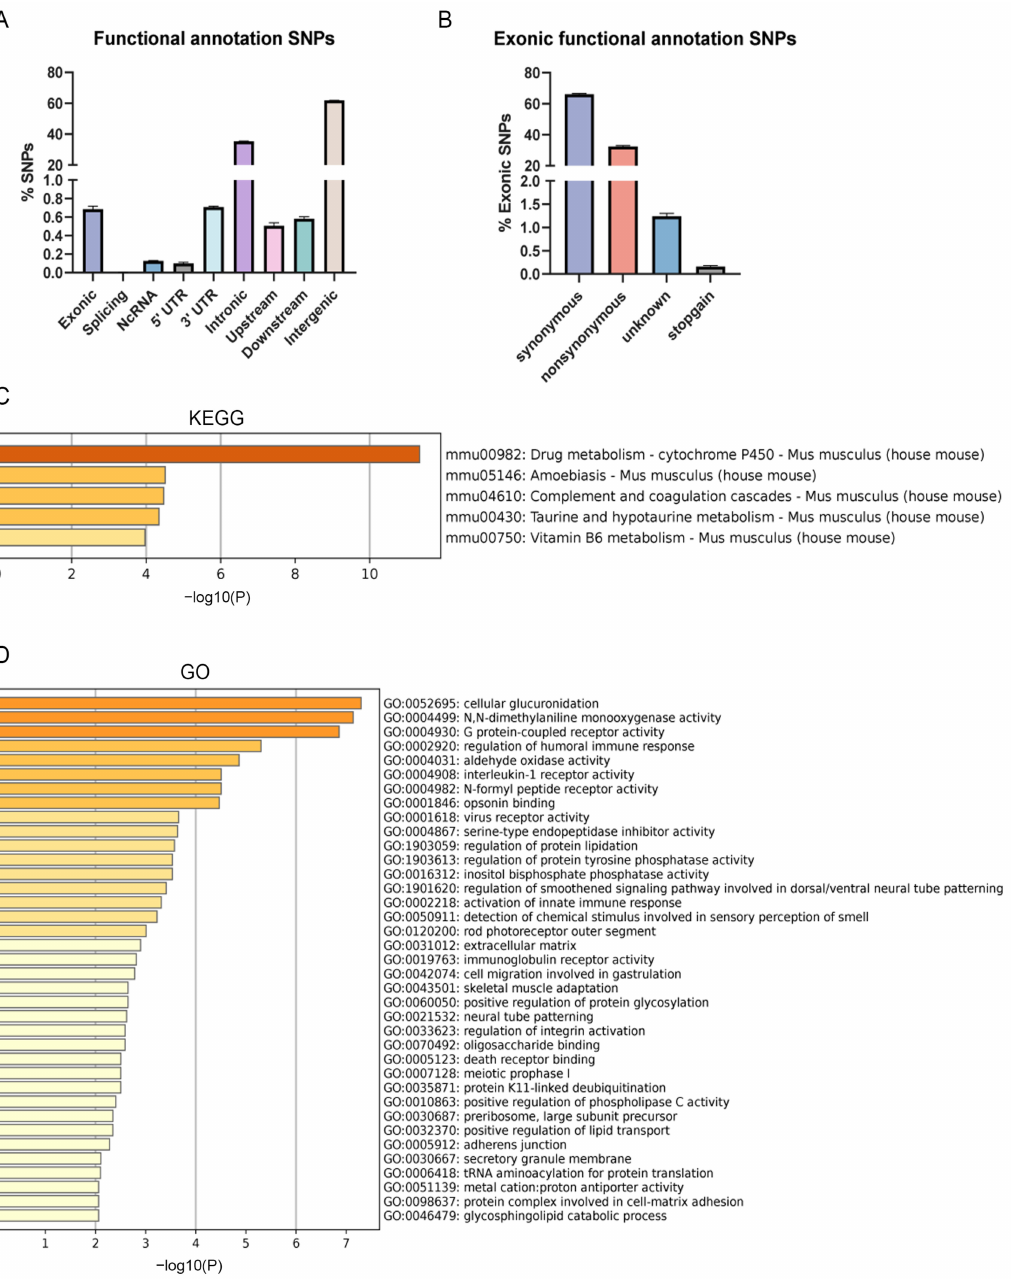
Figure 5. SNP analysis of B6-Chr1BLD mice. ( A ) Distribution of functional consequences of SNPs. ( B ) Distribution of types of SNPs (synonymous and non-synonymous) in the exonic region. Non- synonymous SNPs and stopgain SNPs were used for further SNP enrichment analysis. ( C ) Enriched KEGG terms. ( D ) Enriched GO